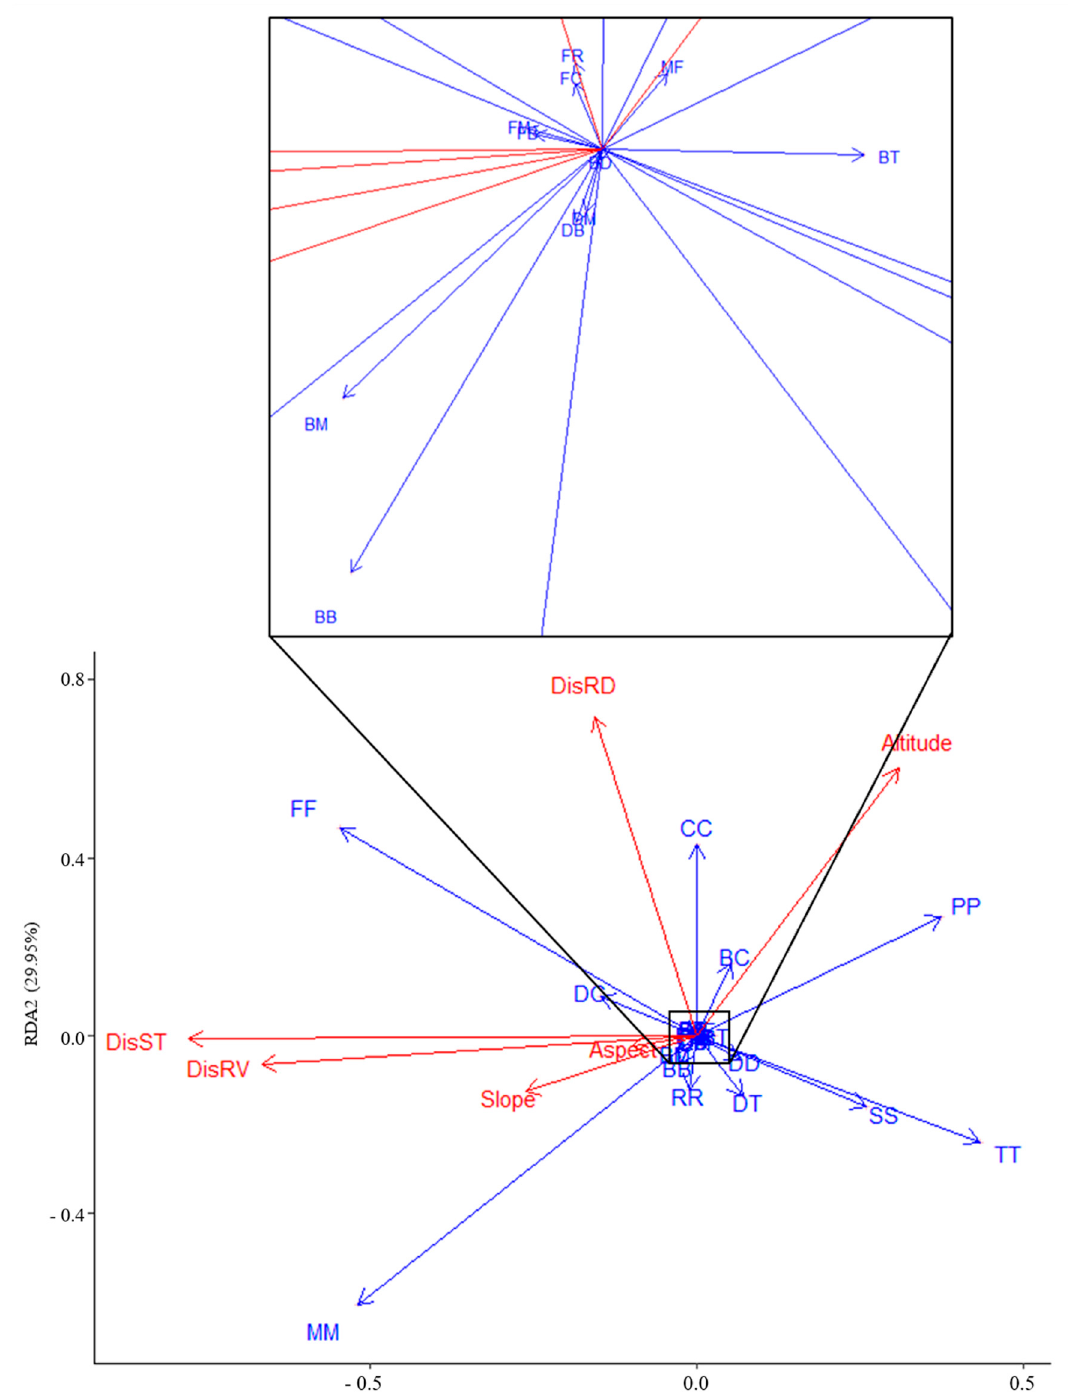
Figure 10. RDA ordination of land-use change trajectories (blue arrows) in relation to environmental variables (red arrows) for 2019–2020. DisRV: distance to rivers; DisRD: distance to roads. DisST: Distance to settlement. Arrows represent relative values of environmental variables and land-use change trajectories. Correlations between environmental variables and land-use change trajectories are indicated by the cosine of angles between the corresponding arrows; with <90° indicating a positive correlation and >90° a negative correlation. With projection of arrows for land-use change trajectories into arrows for corresponding environmental variables, the distance from the origin to the projection point indicates the relative value of the environmental variable where land-use change is most likely to occur.